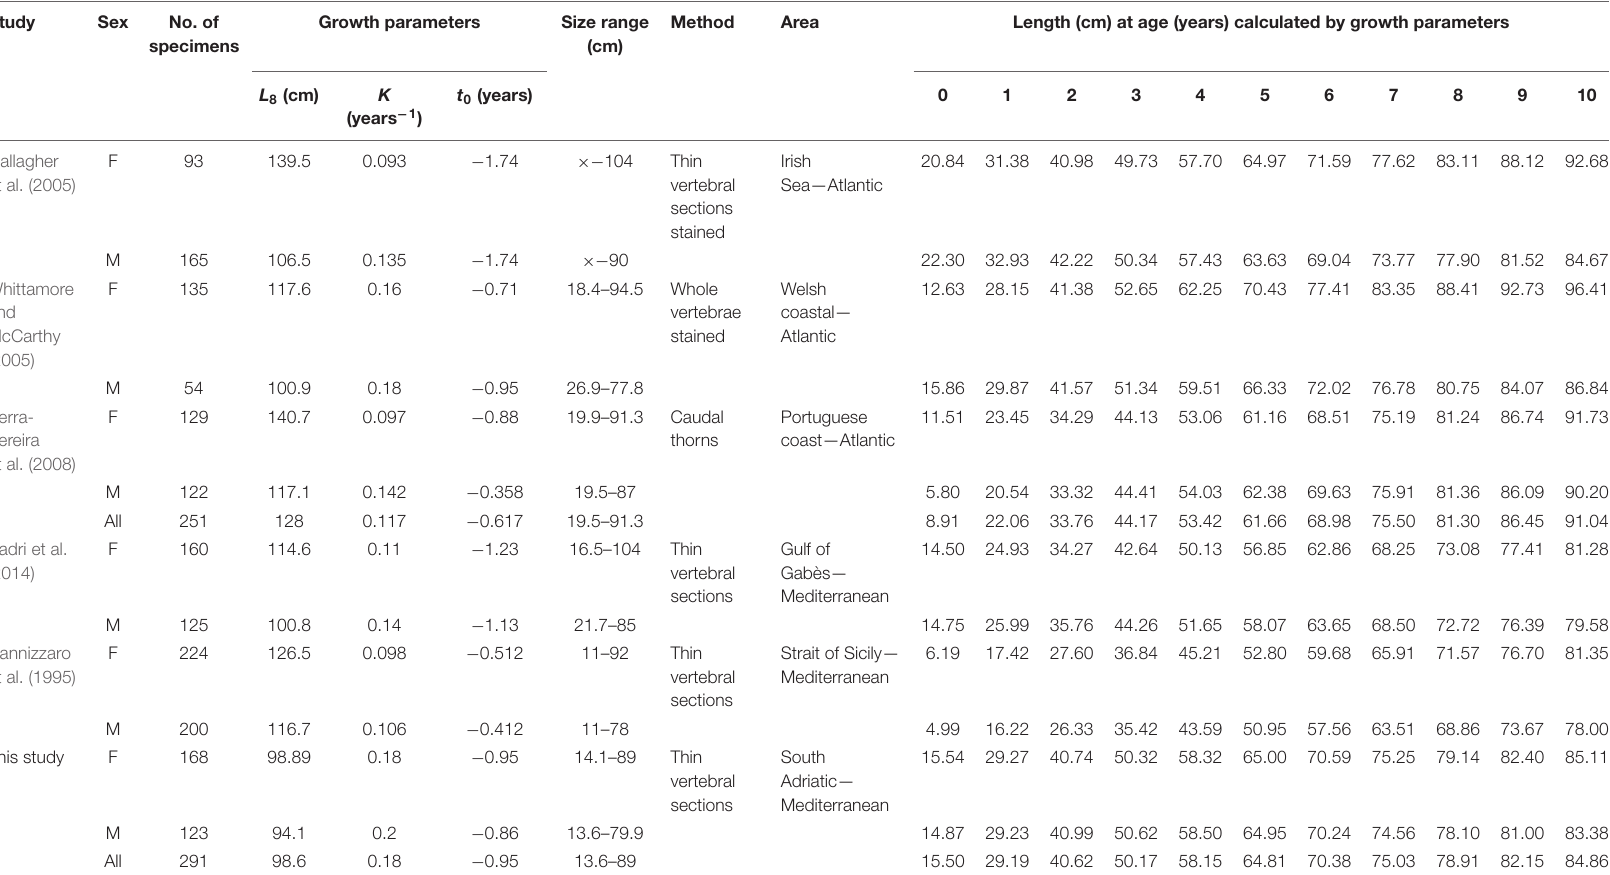
TABLE 4 | Raja clavata growth parameters and estimated length (cm) at age (from 0 to 10 years) by sex, geographical area, and age estimation method. Study Sex No. of